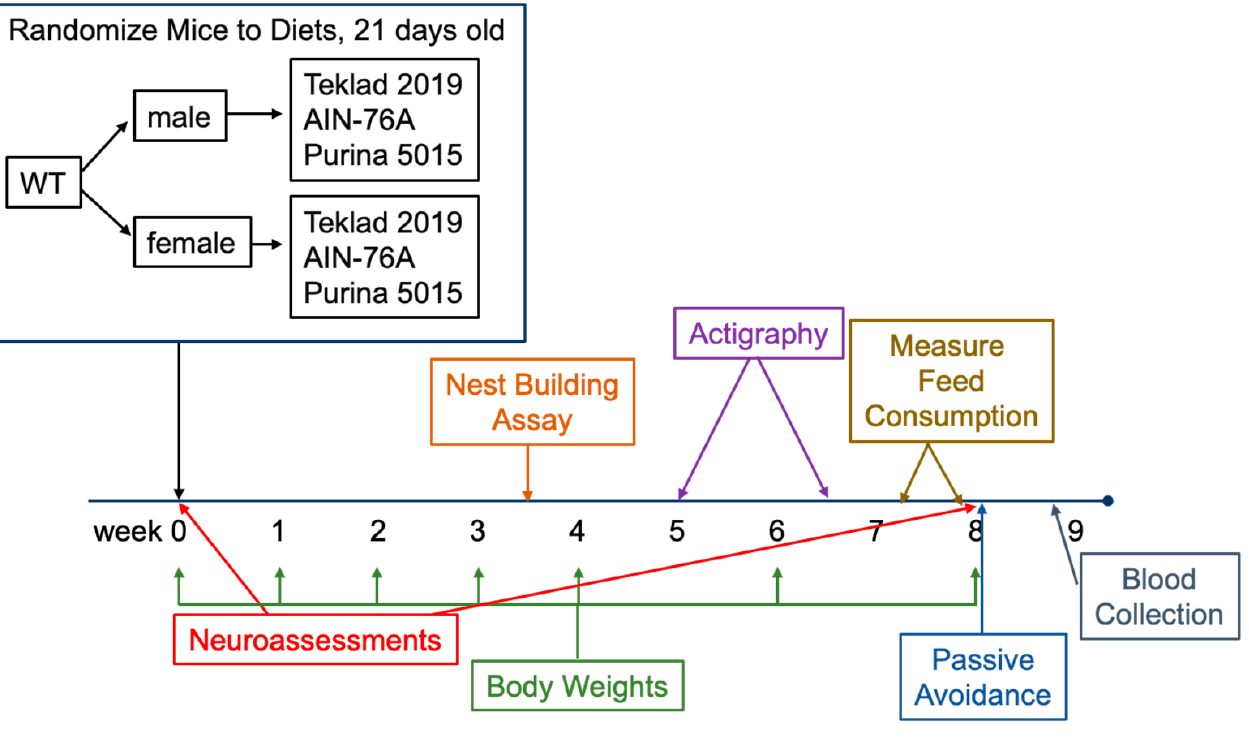
Figure 1. Study Design. Mouse Behavior: Mice underwent an abbreviated Irwin murine